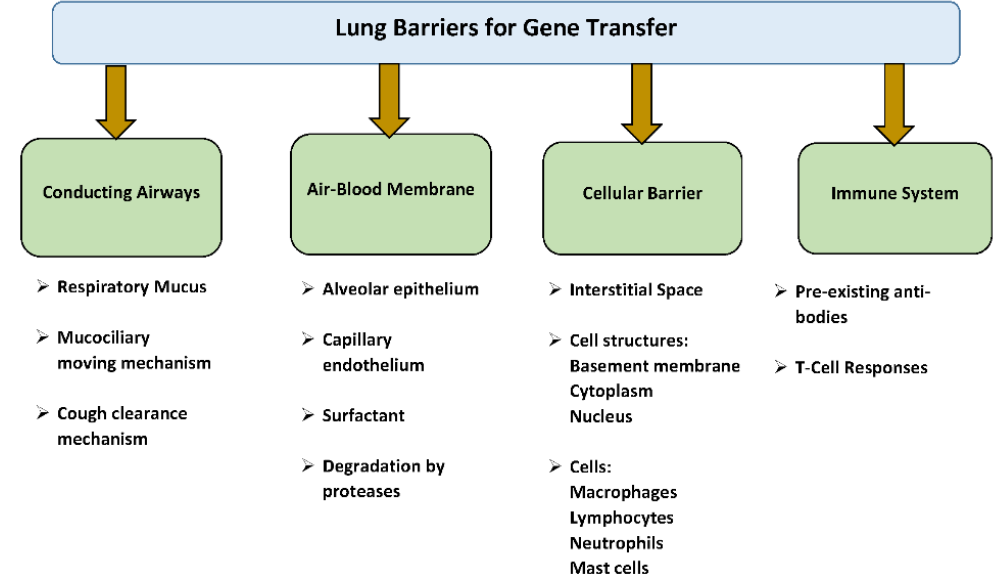
Figure 1. Lung barriers for gene transfer.